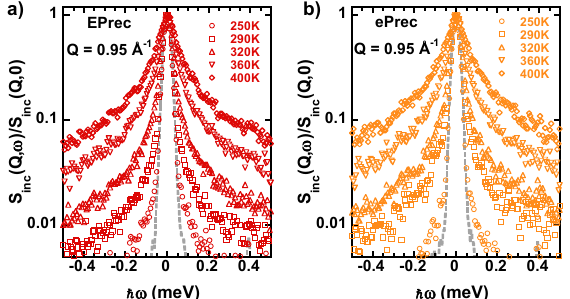
Fig. 3. Normalized FOCUS spectra obtained at Q = 0.95 and the different temperature values indicated for (a) Å (cid:6)(cid:7) EPrec sample and (b) ePrec sample. The dotted line shows the instrumental resolution